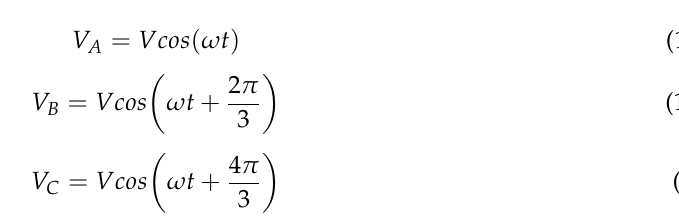
Figure 1. ( a ) Three-Phase Phasor Diagram; ( b ) symmetrical Six-phase Phasor Diagram; ( c ) asymmetrical Six-phase Phasor Diagram.